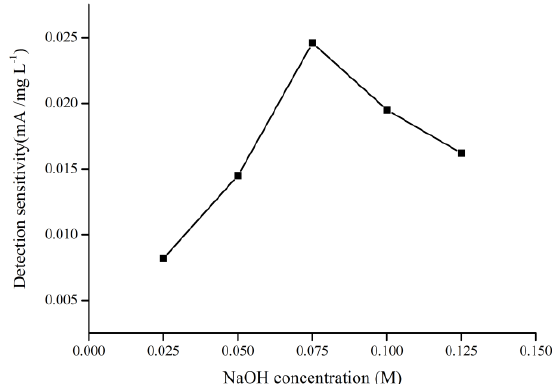
Figure 7. The correlation between sensitivity to COD on the CuO/CuNWE and NaOH concentration.